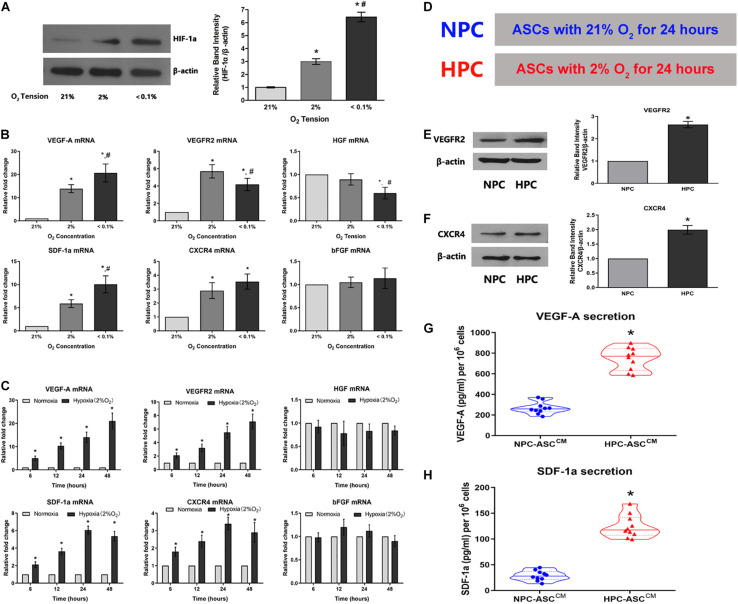
Hypoxia enhances the expression of the HIF-1a and the expression of its downstream pro-angiogenic genes in ASCs. (A) Hypoxia caused an O2-concentration-dependent increase in HIF-1a protein levels after 24 h (n = 5, * denotes P < 0.05 vs. the 21% O2 group, #denotes P < 0.05 vs. the 2% O2 group). (B,C) The degree and duration of hypoxia regulate mRNA expression of the pro-angiogenic genes (VEGF-A, VEGFR2, HGF, SDF-1a, CXCR4, and bFGF) in ASC (n = 6, * denotes P < 0.05 vs. the 21% O2 group; #denotes P < 0.05 vs. the 2% O2 group). (D) Normoxic preconditioning (NPC) indicates treatment of ASCs with 21% O2 for 24 h; hypoxic preconditioning (HPC) indicates treatment of ASCs with 2% O2 for 24 h. (E,F) Representative western blots of VEGFR2 and CXCR4 in ASCs with HPC and NPC. Quantification of VEGFR2 and CXCR4 protein levels (normalized to β-actin protein levels) was expressed as relative ratios (n = 5, * denotes P < 0.05 vs. NPC group). (G,H) HPC increases VEGF-A and SDF-1a secretion in the conditioned medium from ASCs (ASCCM) compared to the NPC (n = 10, *denotes P < 0.05 vs. NPC-ASCCM).